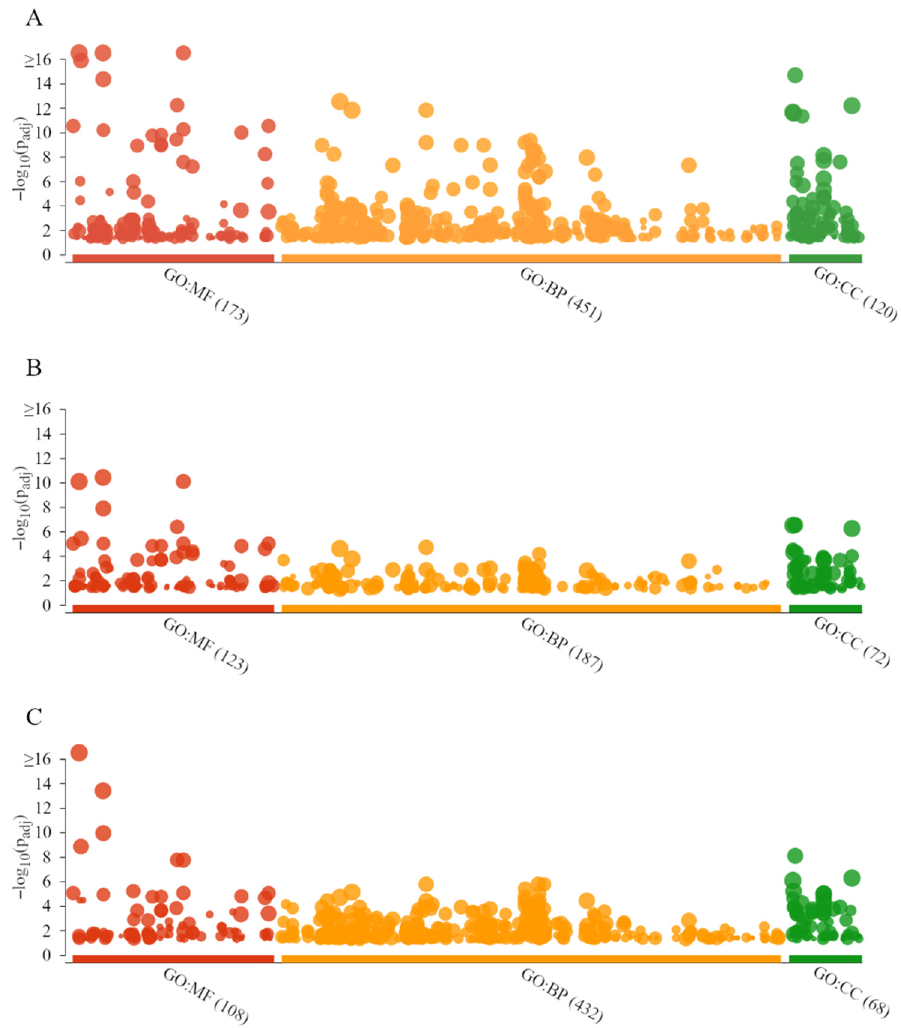
Figure 6. g.GOSt multi-query Manhattan plots showing the functional classification of proteins that were present in the epididymal spermatozoa of dogs ( Canis lupus familiaris ) in different age groups: G1 ( A ), G2 ( B ), and G3 ( C ). The x -axis represents Gene Ontology (GO) functional terms, grouped and color-coded by data sources: molecular function (GO:MF, red), biological process (GO:BP, orange), and cellular component (GO:CC, green). The y -axis shows the adjusted enrichment p -values in negative log10 scale. Circles illustrates the enrichment of GO terms and shows the p -value. The circle sizes are in accordance with the corresponding GO term size. The number behind the source name in the x -axis labels shows how many significantly enriched GO terms there were from this source.